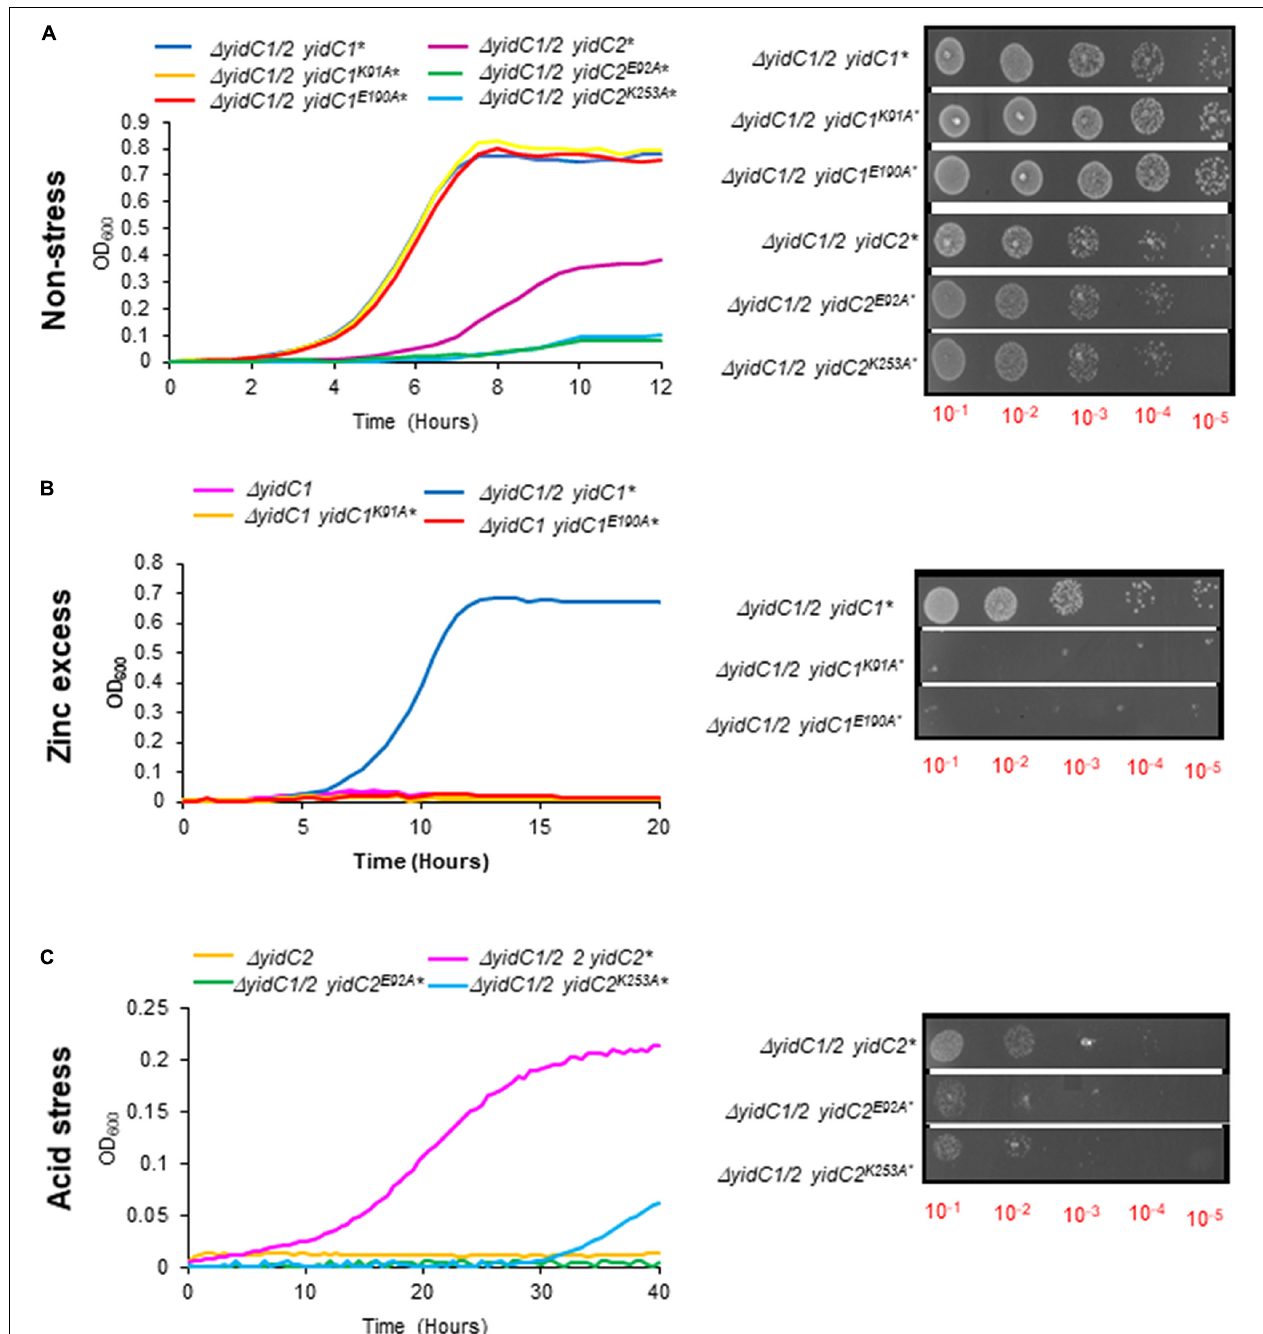
FIGURE 8 | Growth kinetics and efficiency of plating assay of S. mutans strains expressing yidC1 or yidC2 containing point mutations of residues predicted to contribute to salt bridge formation. Growth of strains complemented by ectopic expression (*) from the gtfA locus of unmodified yidC1, yidC2 , or yidC1 or yidC2 containing the indicated point mutations, in a double (cid:49) yidC1/ (cid:49) yidC2 background under (A) non-stress (THYE, pH 7.0), (B) zinc excess (THYE containing 2.5 mM ZnCl 2 ), or (C) acid stress (THYE, pH 5.0)